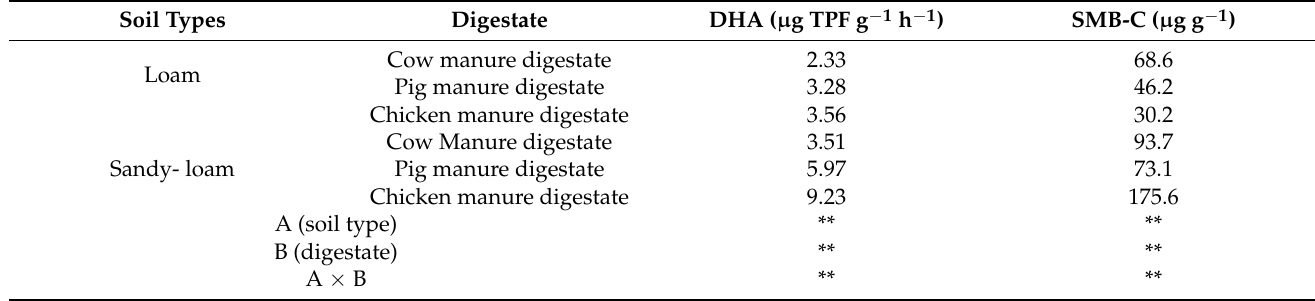
Table 6. Effect of digestate fertilization on soil microbial activities in two soil types: dehydrogenase activity and soil microbial biomass-carbon.